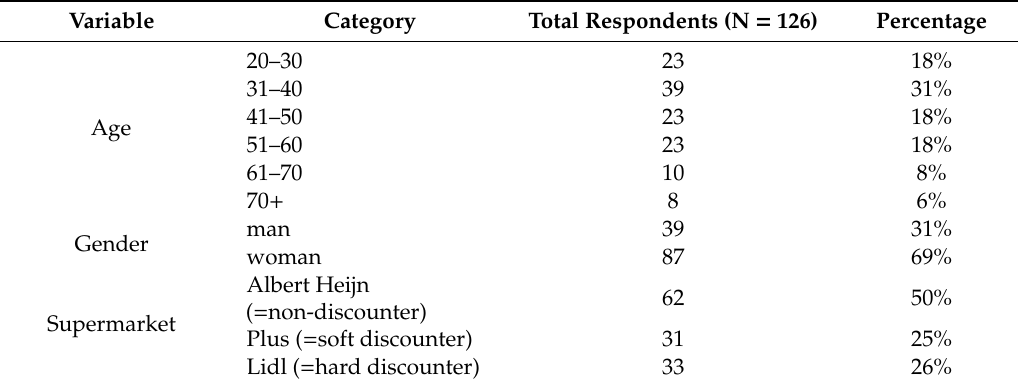
Table 2. Classification of the